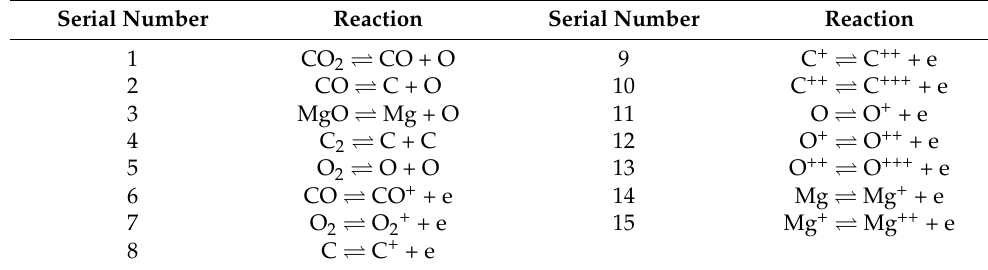
Table 2. The chemical reactions list of in magnesium oxide crystal arc plasma. Serial